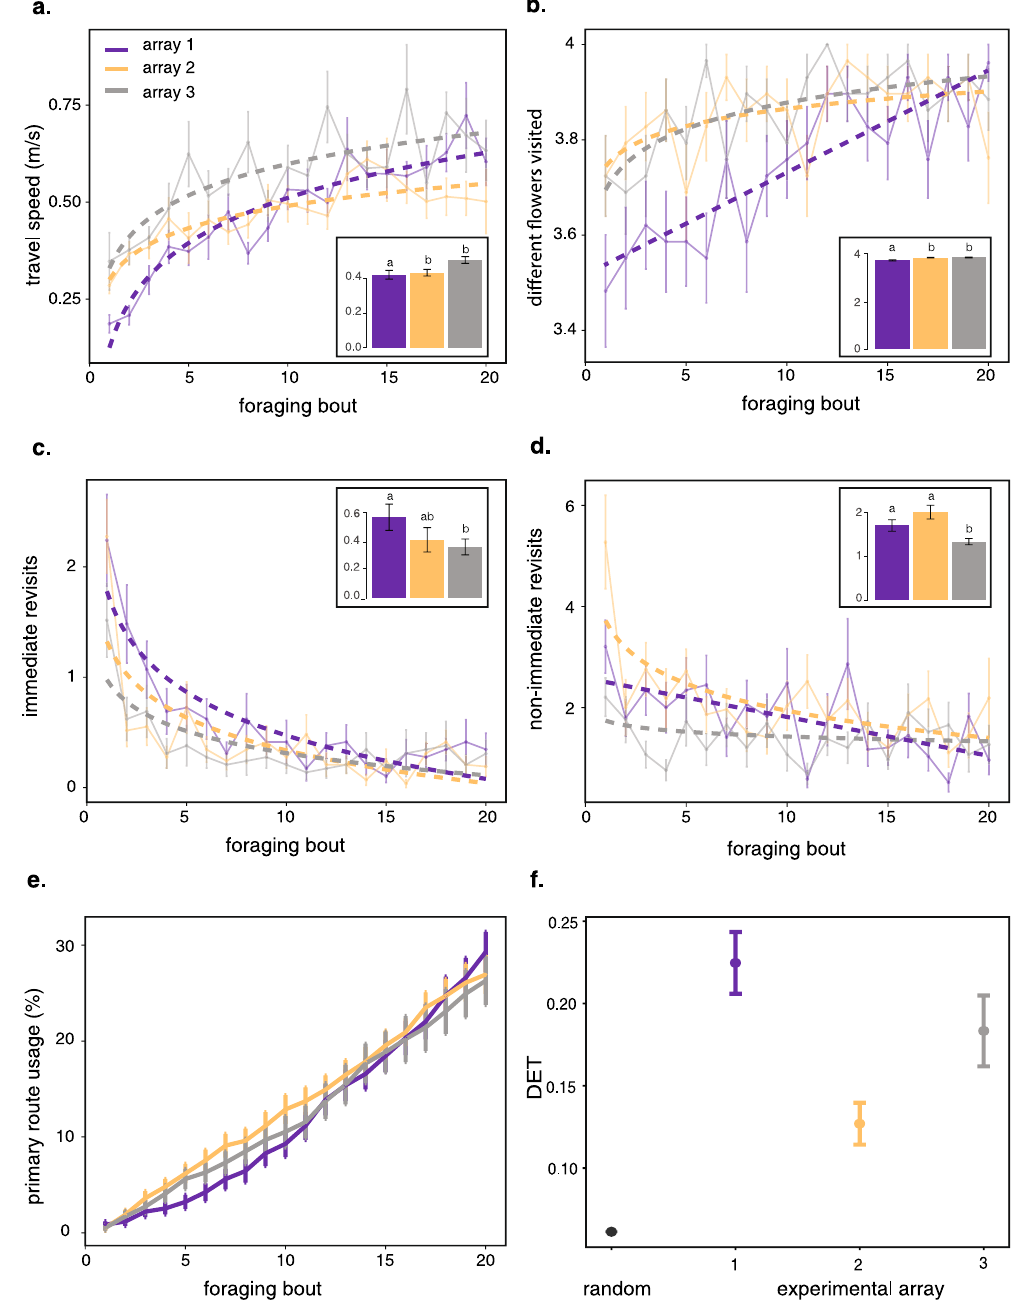
Figure 2. Average behavioural measures in the three experimental arrays (array 1: purple, array 2: orange, array 3: grey, see details of flower and landmark configurations in Fig. 1). ( a ) Travel speed per foraging bout (flight duration divided by the Euclidian distance between all successively visited flowers). ( b ) Number of different flower visited per foraging bout. ( c ) Number of immediate revisits to flowers per foraging bout (when the bee visited the same flower twice in a row). ( d ) Number of non-immediate revisits per foraging bout (when the bee revisited a flower after having visited one or more different flower locations). ( e ) Cumulative frequency of primary route usage per foraging bout. ( a – e ) plain lines show means ± SE (N = 29 bees), dashed lines show regression models (see details in Table 1 and Supplementary Table S1). ( f ) Comparison between simulated random determinism index (DETs, N = 1000 simulations) and observed DETs (N = 29 bees) in each experimental array (mean ± SE). ( a – d ) Bar plots show means ± SE for each array of flowers. Tukey post-hoc analysis: different letters above bars represent significant differences between arrays (see details in Supplementary Table